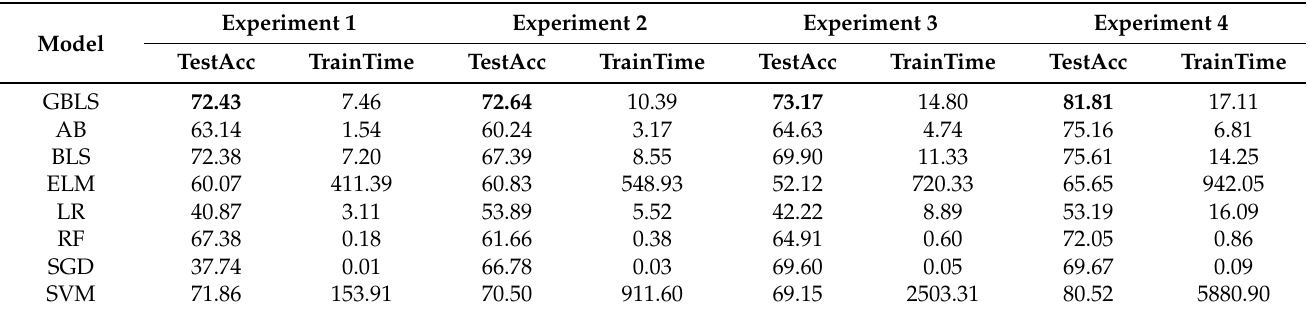
Table 3. Test accuracy (%) and training time (s) of models on imbalanced data sets. In the first experiment, the training set contains 25,008 data points from Region I whereas the remainder is considered as test data. Similarly, Experiment 2 contains 47,905 training data points from Region I and II, Experiment 3 contains 69,990 training data points from Region I to III, and Experiment 4 contains 99,217 training data points from Region I to